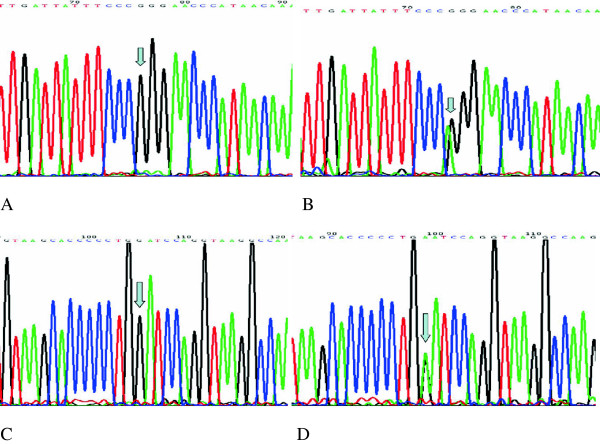
Genetic sequencing maps of CYP2C19*2 and CYP2C19*3. The arrows were pointing to the genetic single nucleotide polymorphisms of CYP2C19. Fig. A: wild-type of CYP2C19*2, Fig. B: heterozygous of CYP2C19*2, Fig. C: wild-type of CYP2C19*3, Fig. D: heterozygous of CYP2C19*3.